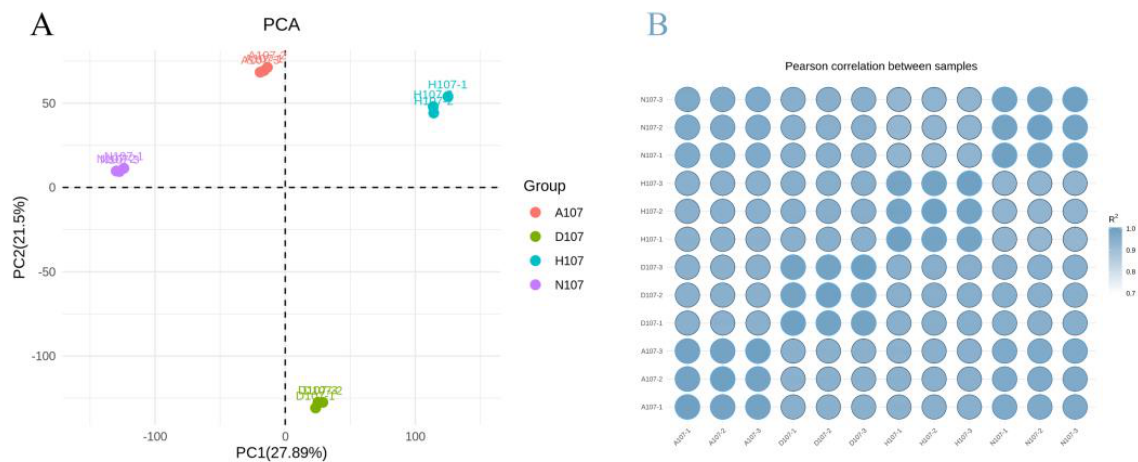
Figure 2. Analysis of the relationship between the samples under hypoxia and acidification stress in L. crocea . ( A ) PCA of the different transcriptome samples; ( B ) heatmap depicting the inter −− sample correlation coefficients.